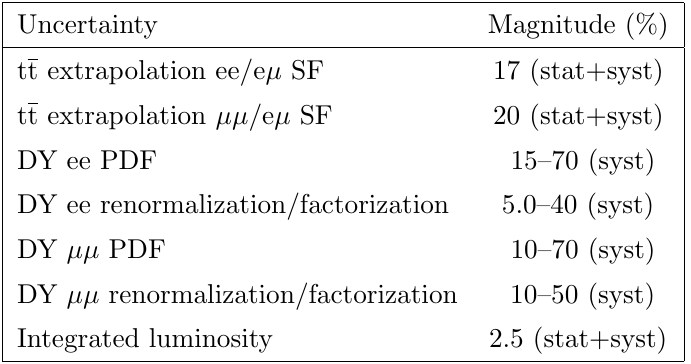
Table 3 . Uncertainties a(cid:11)ecting the m ‘‘ jj distribution shape and normalization. The uncertainties in the tt SFs a(cid:11)ect the tt background, the uncertainties in the DY PDF and the DY factorization and renormalization scales a(cid:11)ect the DY+jets background, and the uncertainty in the integrated luminosity a(cid:11)ects both signal and